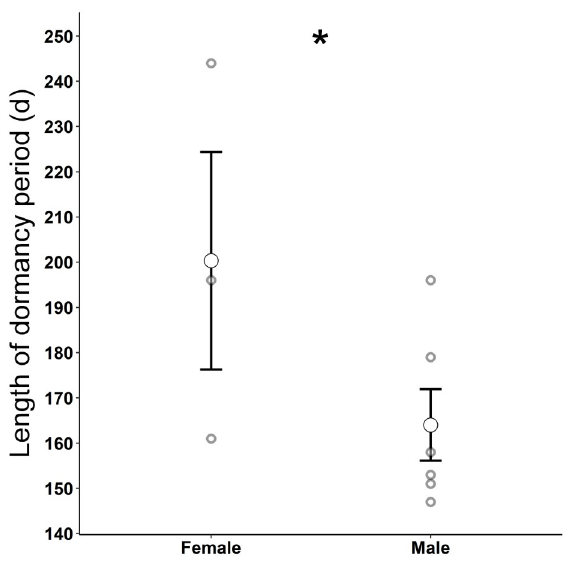
Fig 4. Sex specific mean length of tegu dormancy. Mean length of dormancy (open circles) of three female and six male Argentine Black and White Tegus ( Salvator merianae ) with error bars representing the standard error of the mean. Gray circles show length of dormancy for individuals and asterisk indicates statistically significant difference among